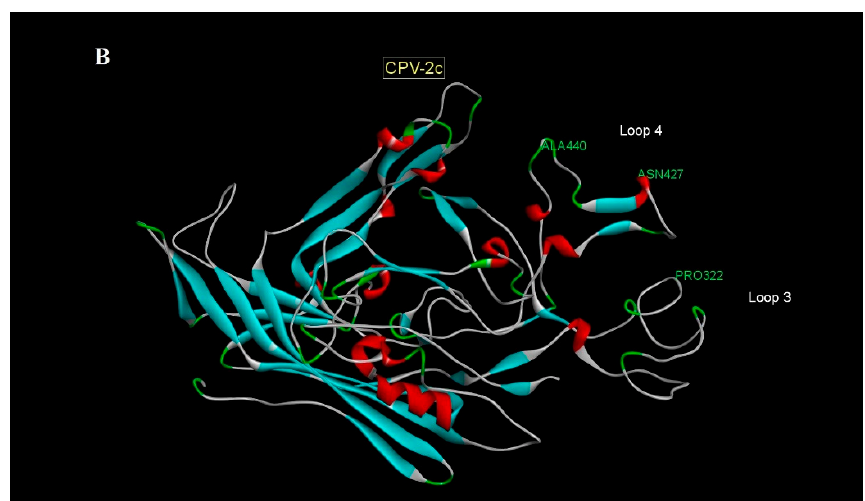
Figure 2. Modeling of the VP2 structure, indicating the substitutions on the triple spike. ( A ) Representation of more relevant substitutions in variant CPV-2b at sites A297N and Y324I; and ( B ) CPV-2c at sites T322P, D427N and T440A. For the modeling of amino acid substitutions, the Phire 2 platform (http://www.sbg.bio.ic.ac.uk/phyre2/html/page.cgi?id=index, accessed on 10 May 2021) [32] was used and visualized using Discovery Studio Visualizer Server Copyright © 2019. Table 2. Selection pressure on VP2 in the sequenced samples. Selection Pressures on the Genome of the VP2 Canine Parvovirus Sites of Positive Selection Sites of Negative